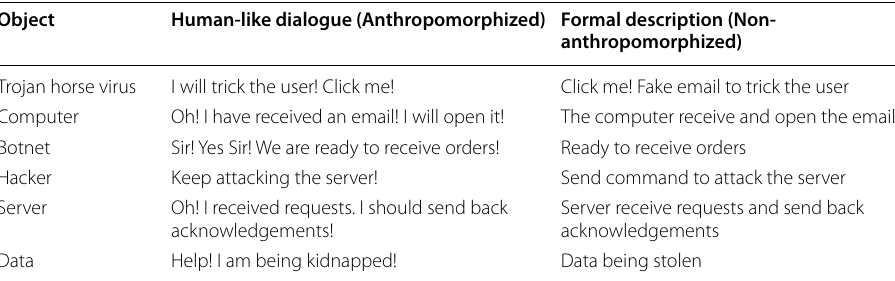
Table 2 The on‑screen human‑like dialogues versus the formal descriptions of the learning‑relevant